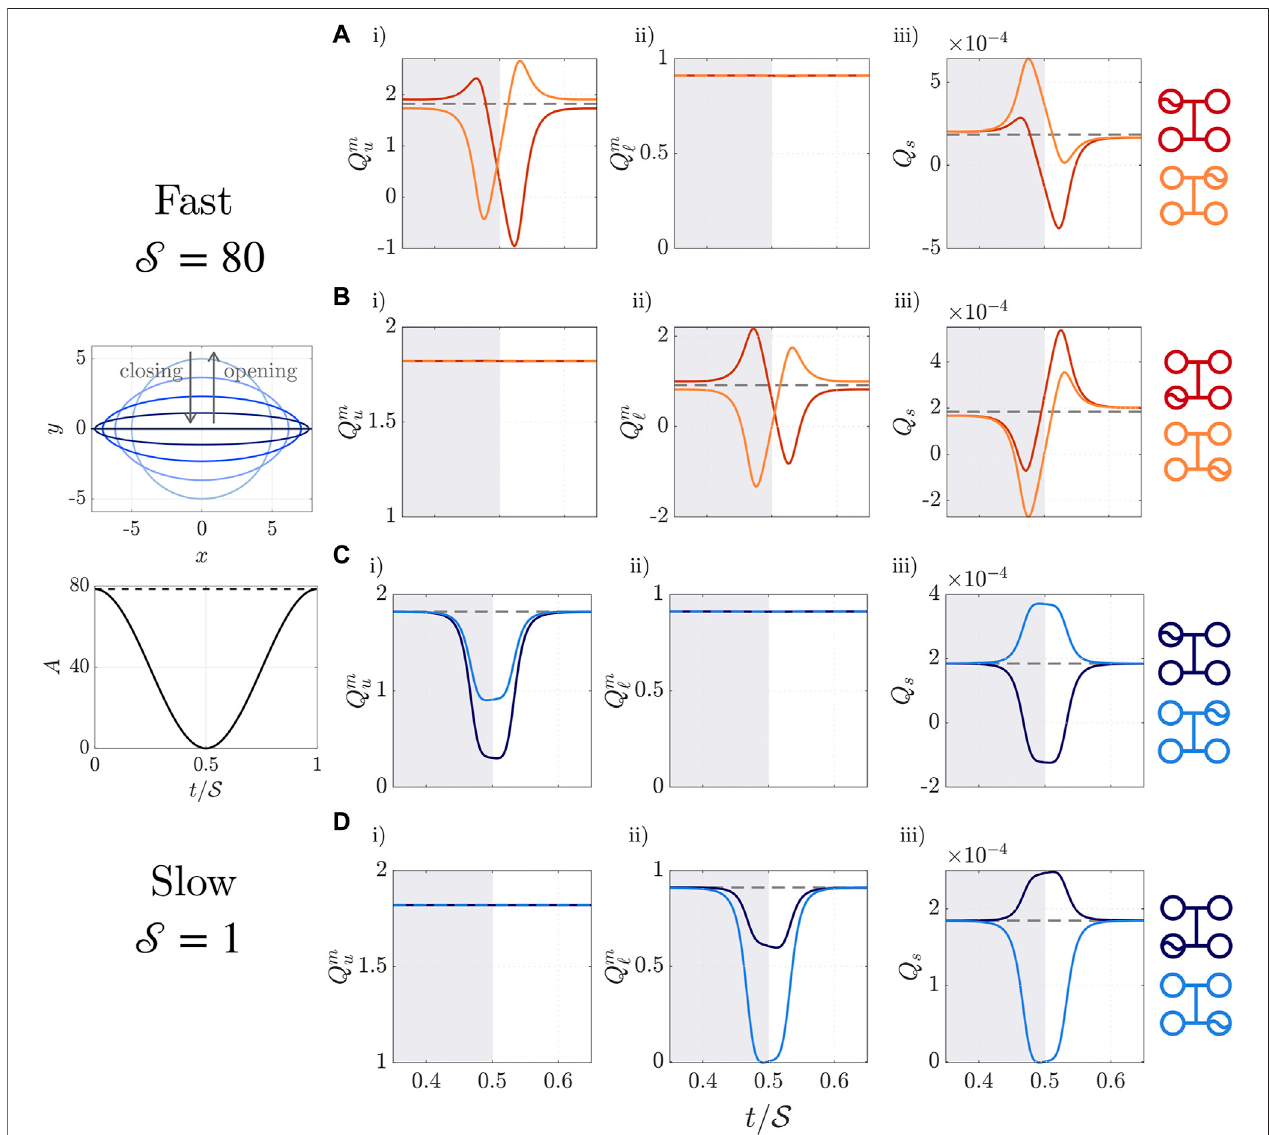
FIGURE6| Dimensionless fl uxes Q m u , ℓ throughthechannelmidpoints,anddimensionless fl ux Q s throughthescaffold,whenthreevalvesareopen.Lowerleftshows the area ofthe moving valve varying in time: initially, it isopen, then closes in t / S ∈ ( 0 , 0 . 5 ) (shaded grey in (A – D) ),and reopens in t / S ∈ ( 0 . 5 , 1 ) (unshaded in (A – D) ). The dottedlineistheareawhenopen.Upperleftshowsthevalvecross-sectionclosing,lighttodarkerbluecorrespond to t / S (cid:2) 0 , 0 , 0 . 1 , 0 . 2 , 0 . 3 , 0 . 5.Sub fi gures (A,B) show valves moving quickly, with a period of T = 0.49 s, so that S (cid:2) 80. Sub fi gures (C,D) show valves moving slowly, with a period of T = 40 s, so that S (cid:2) 1. The tilde in the far-right diagrams show which valve is moving: in the fi rst and third rows, upper valves are moving; in the second and fourth rows, lower valves arer moving. The dotted grey lineis the fl ux when all valves are open.Note thatplots show t / S ∈ (0.35,0.65). Lengthscalesare b v * (cid:2) 4 . 9 × 10 − 4 (cid:2) b c *, b r * (cid:2) 10 − 4 , and other parametersare as in Table 1